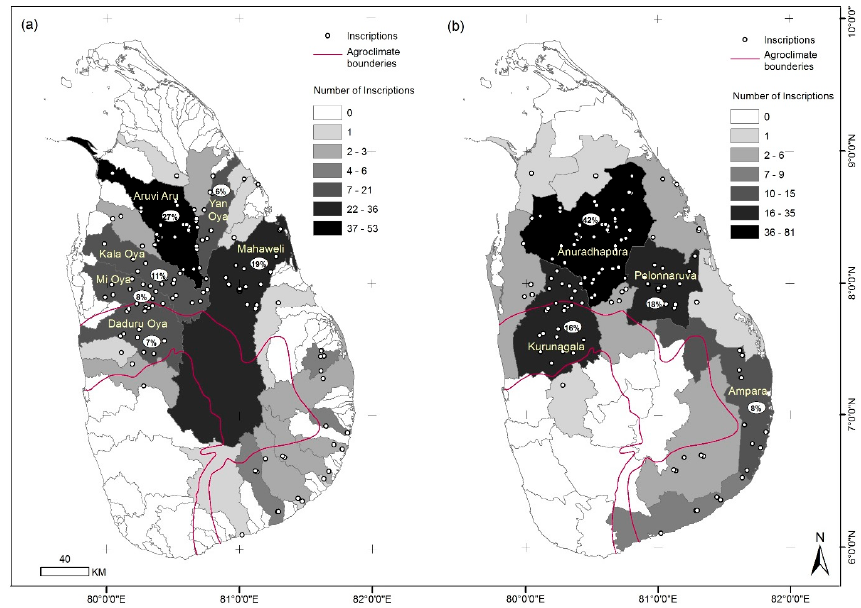
Figure 5. Spatial distribution of lithic inscriptions in Sri Lanka based on river basins and present-day districts. ( a ) Distribution of inscriptions based on river basins. Percentages are mentioned for river basins with >10 inscriptions; ( b ) Distribution of inscriptions based on present-day district boundaries. Percentages are mentioned for river basins with ≥ 10 inscriptions.